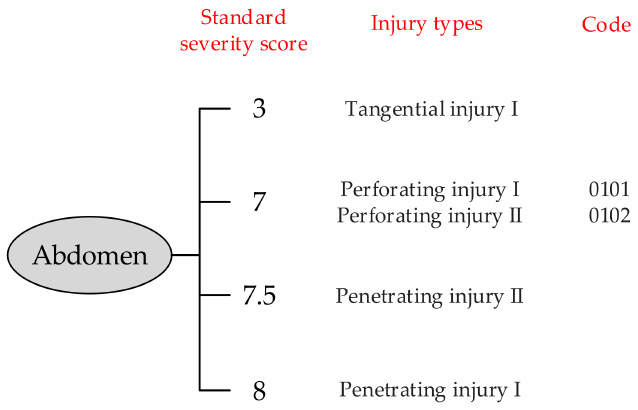
Figure 4. Example of injury coding in the abdominal area.